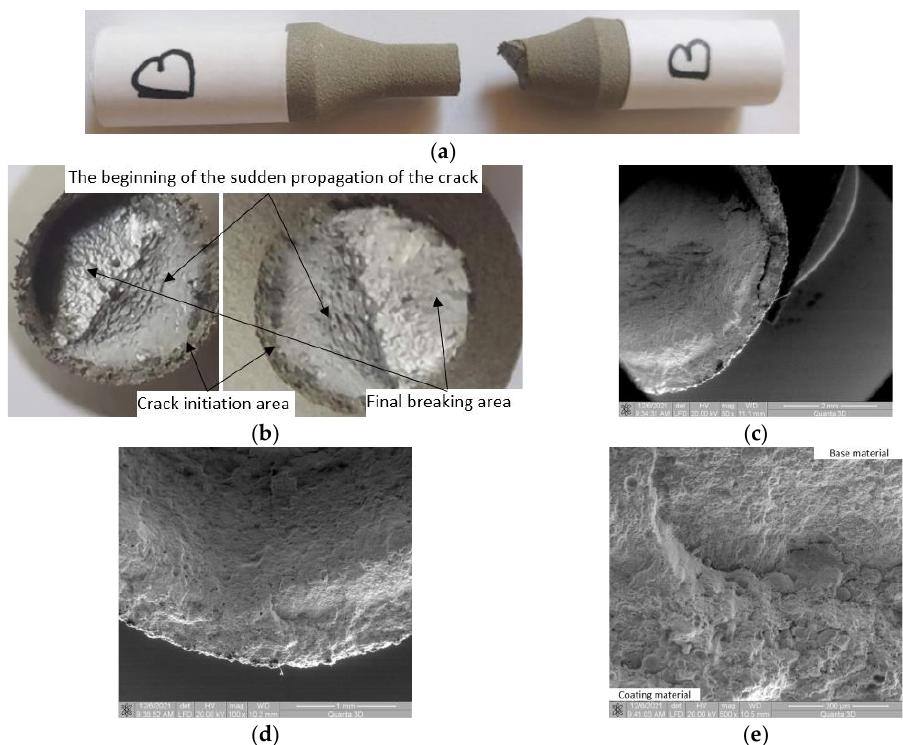
Figure 6. Macroscopic and microscopic images of broken surfaces for samples B and C. ( a ) Speci- men B: Side view of the broken sample. ( b ) Specimen B: Macroscopic images of surfaces resulting from breakage. ( c ) Specimen B: SEM image (50×) of the broken surface at plane deflection. ( d ) Specimen B: SEM image (100×) of the interface area. ( e ) Specimen B: SEM image (500×) with damage in the interface area.